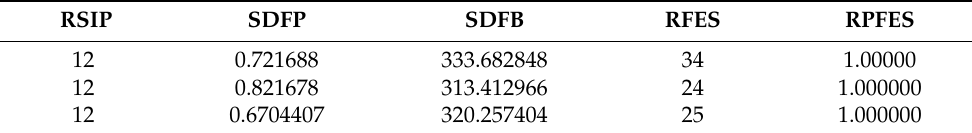
Table 2. Characteristics of the DDoS attacks features.